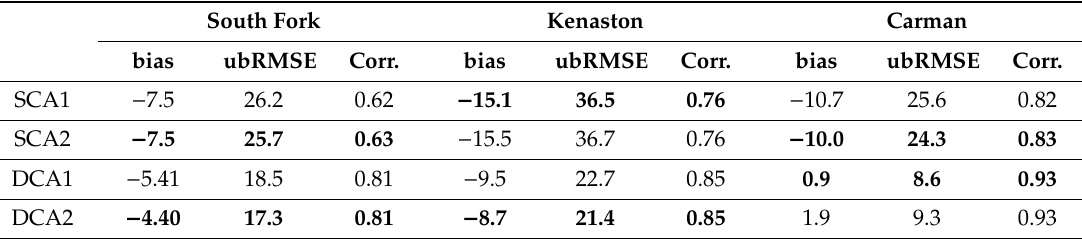
Table 3. Total validation score over USCRN (U.S. Surface Climate Observing Reference Networks) cropland validation site.